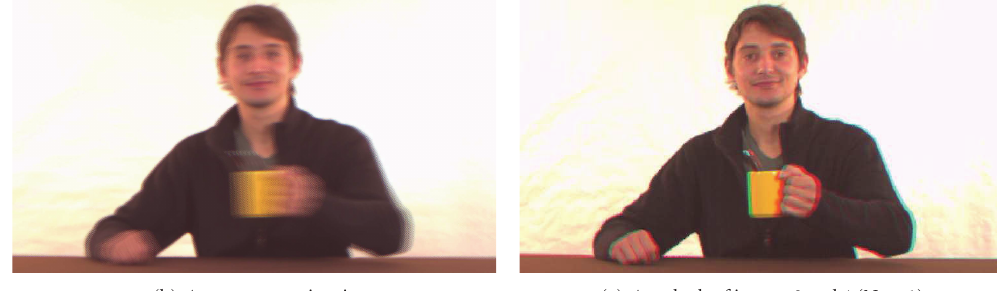
Figure 9: The results of 3D-CAM1.